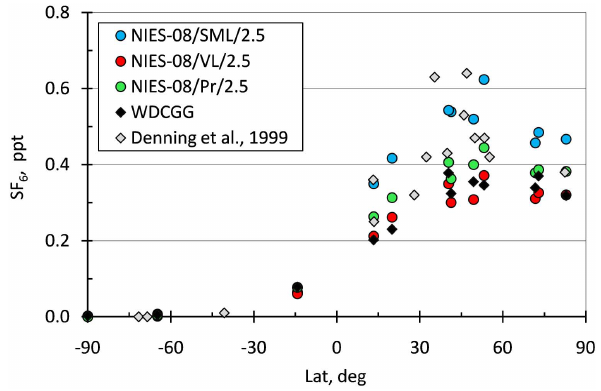
Table 3. List of SF 6 measurements sites from